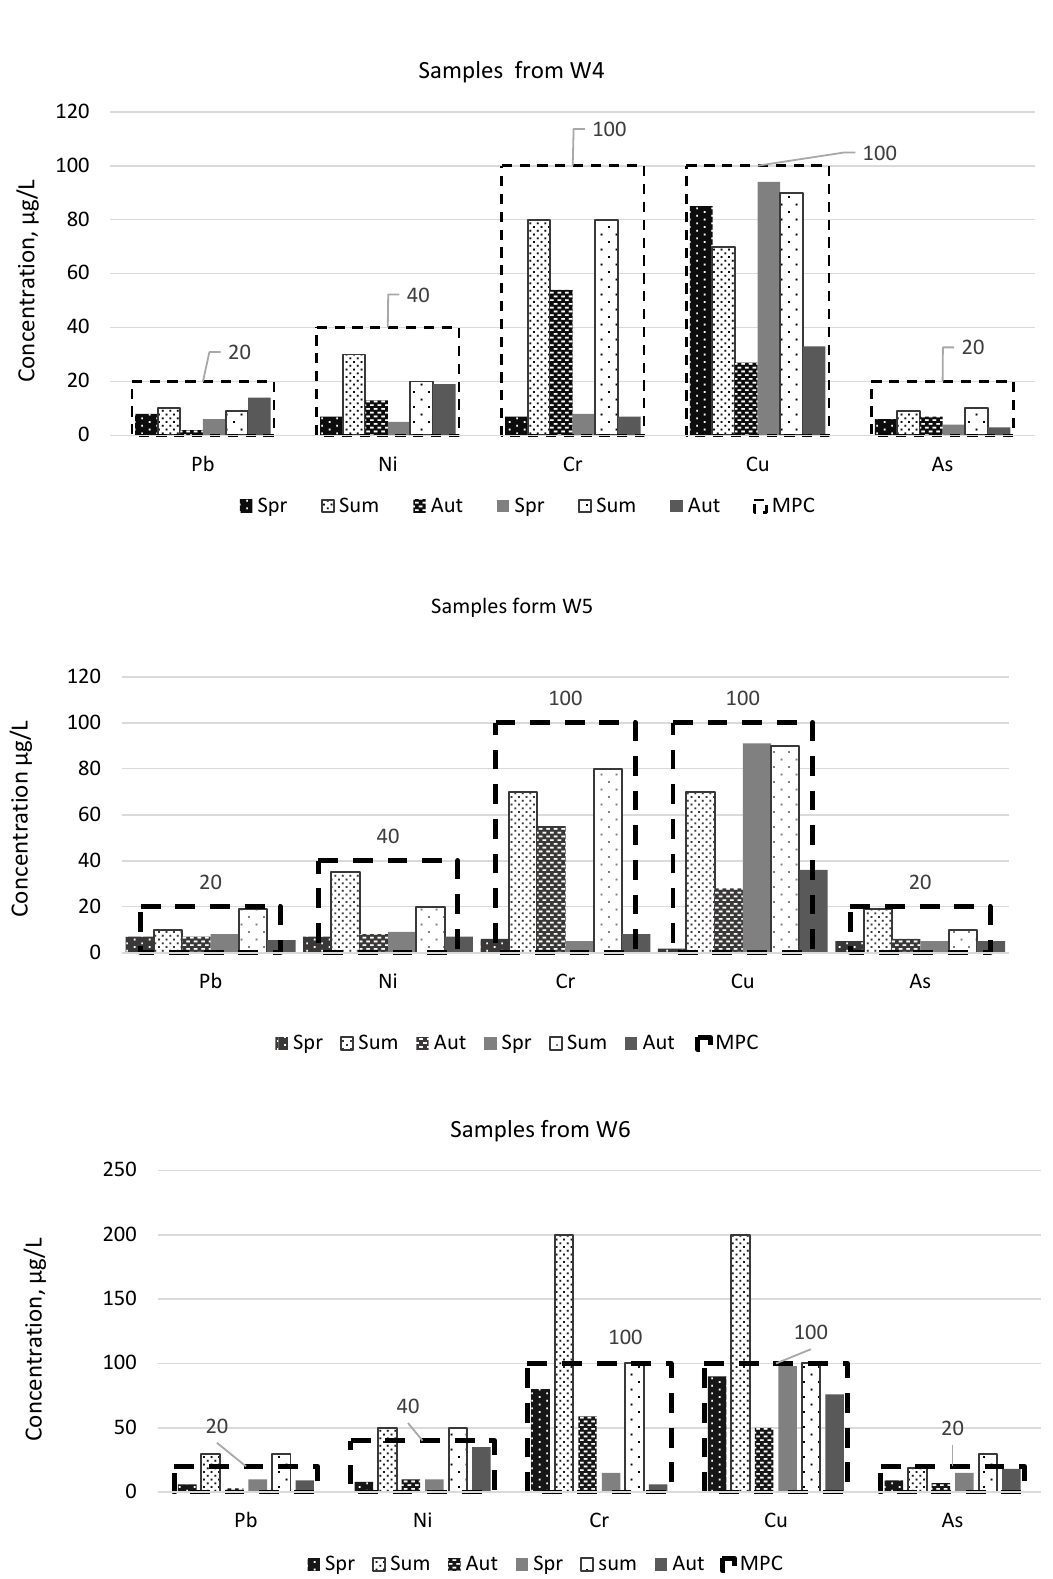
Figure 5. The concentration of heavy metals and metalloid in water of ditch during research period (Aut—autumn season, Sum—summer season, Spr—spring season, MPC—maximum permissible concentration for disposal treated wastewater, according to Waste Water Regulation of the Government of the Republic of Lithuania.